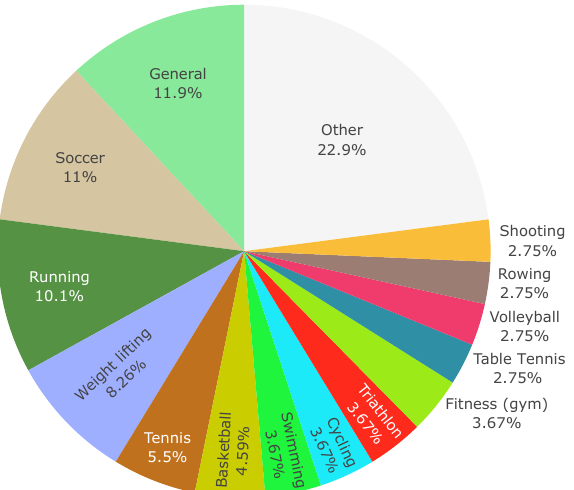
Figure 5. Identified research by the relative frequency of sport it was applied on, rounded to three significant digits.